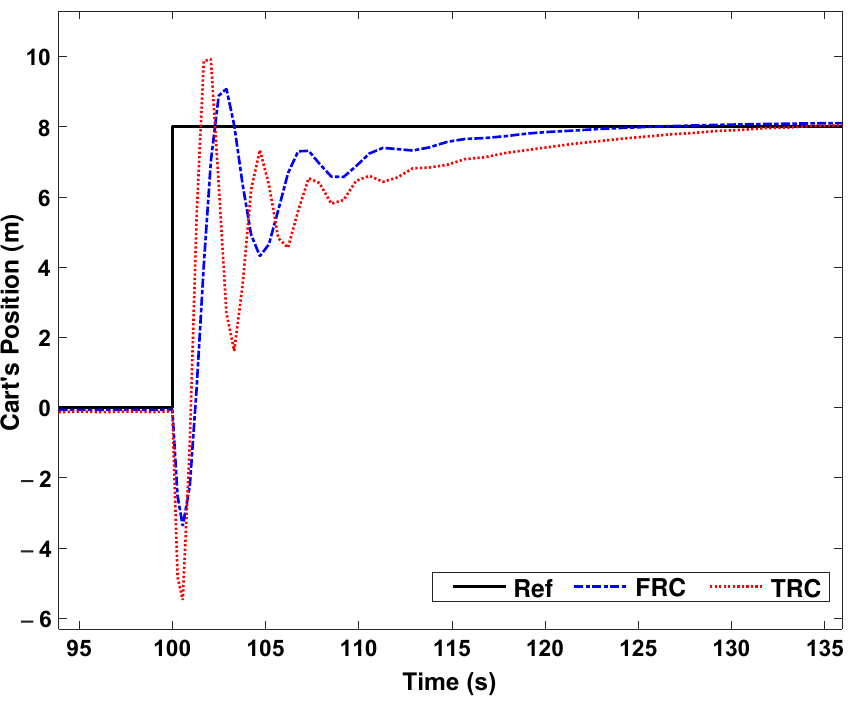
Figure 9. Zoom an area of Figure 8.